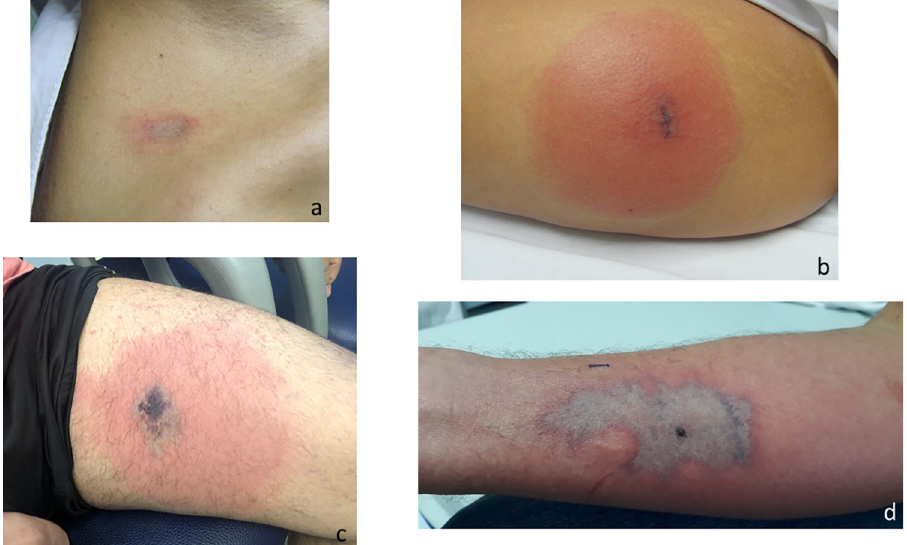
Fig 2. Marbled macula, with and without erythematous halo, after a Loxosceles sp. bite. (a) 18 h after the bite; (b) 24 h after the bite; (c) 72 h after the bite; (d) 120 h after the bite.